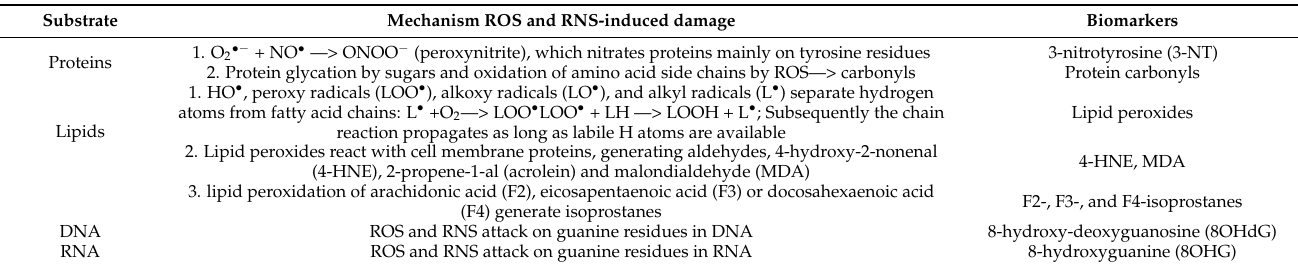
Table 1. Biomarkers of oxidative